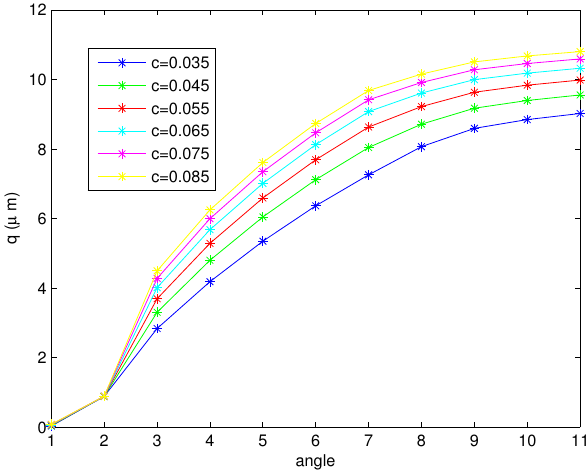
Figure 11. The free surface for the forward stroke at the tips of the cilia at different values of c when r = e θ .